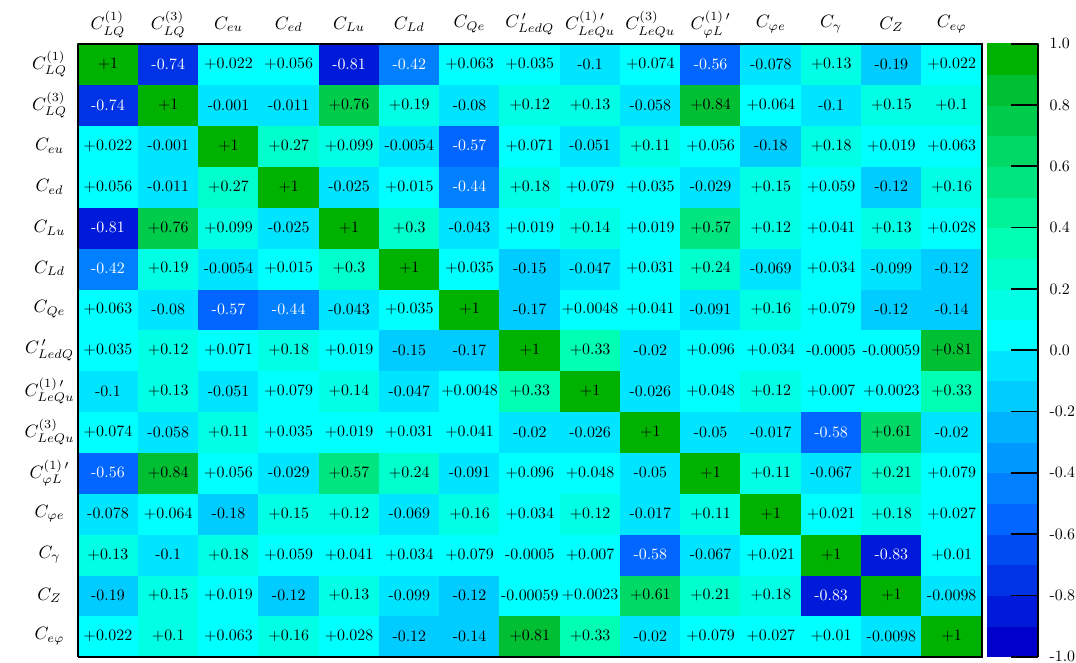
Figure 10 . Correlations among all the Wilson coefficients from the numerical analysis considering Belle limits and including